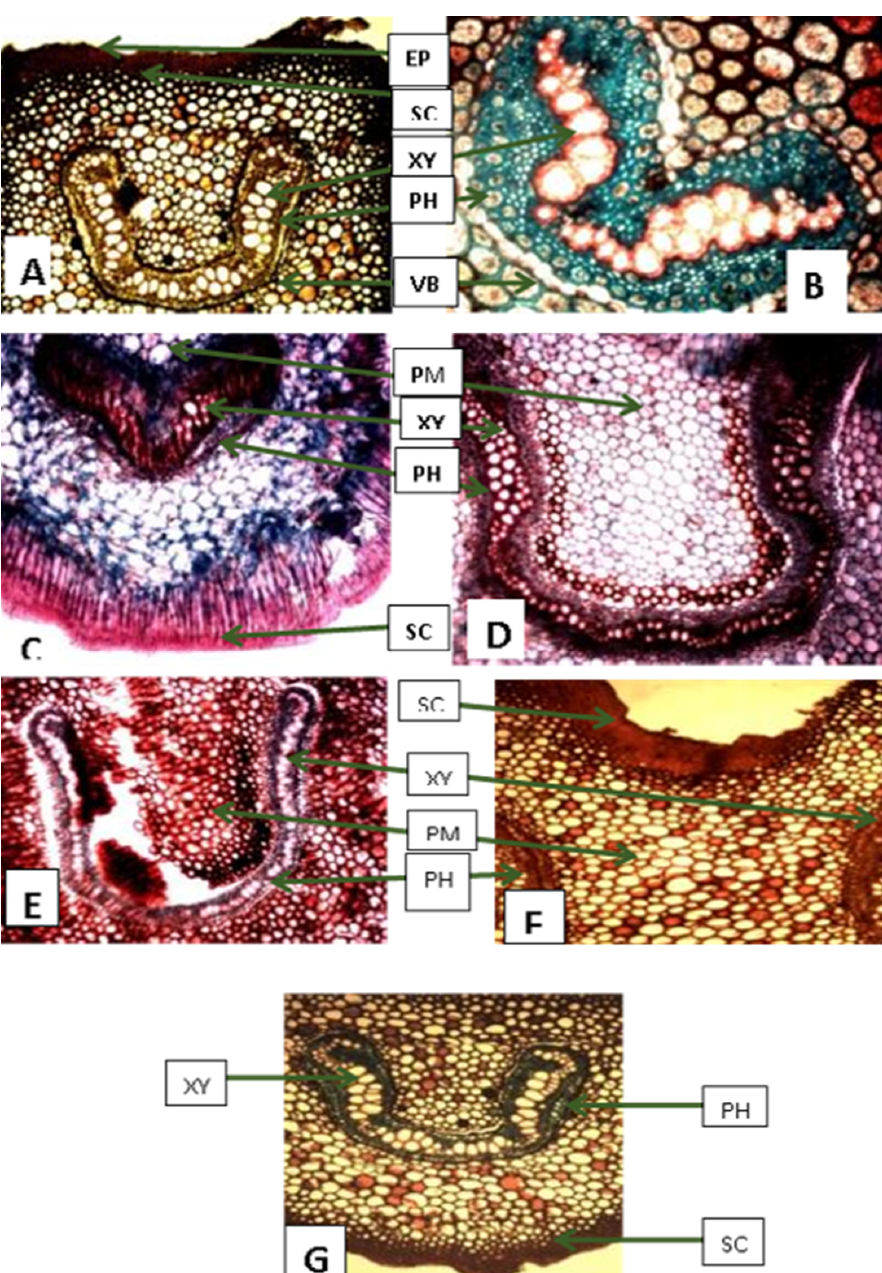
Figure 4. Transverse sections of proximal region of stipes showing cortex in Pteris species. A : P. acanthoneura, B: P. atrovirens , C: P.ensiformis , D: P. mildbraedi, E: P. similis , F: P. togoensis and G: P. vittata Legend: EP: Epidermis, VB: Vascular bundle, SC: Sclerenchyma, PH: Phloem, XY: Xylem, PM: Parenchyma, CO: Cortex., Bar = 1000